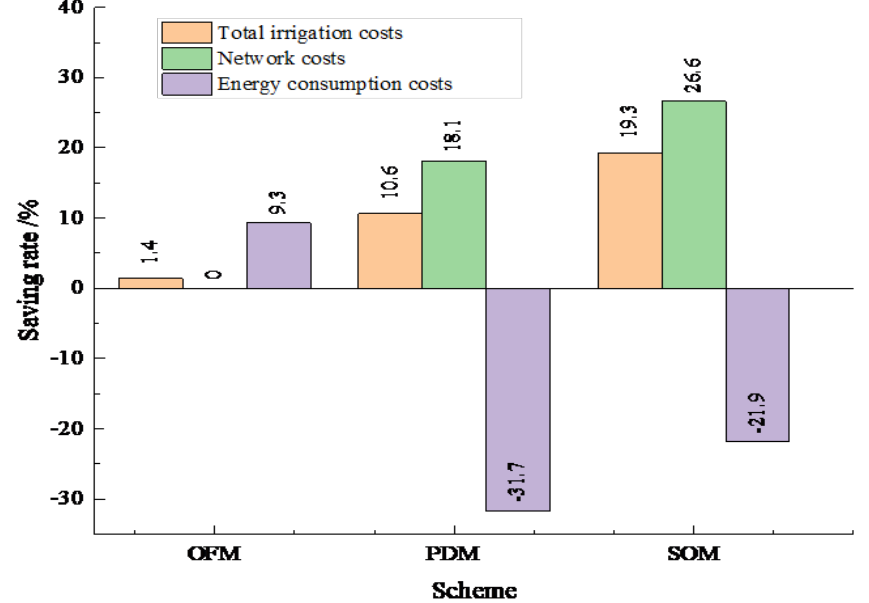
Figure 10. OFM, PDM, SOM compared with the original scheme, the saving rate of total irrigation cost, pipe network cost and energy cost.